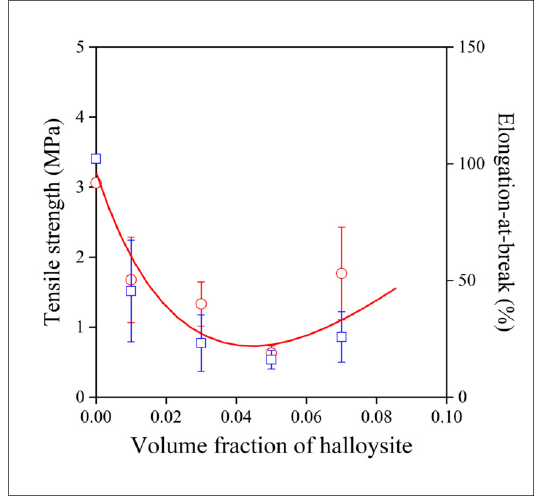
Figure 11. Effect of filler content on the mechanical properties of fiber mats prepared from electrospun PCL/halloysite fibers. Symbols: ( ) tensile strength, ( ) elongation-at-break.